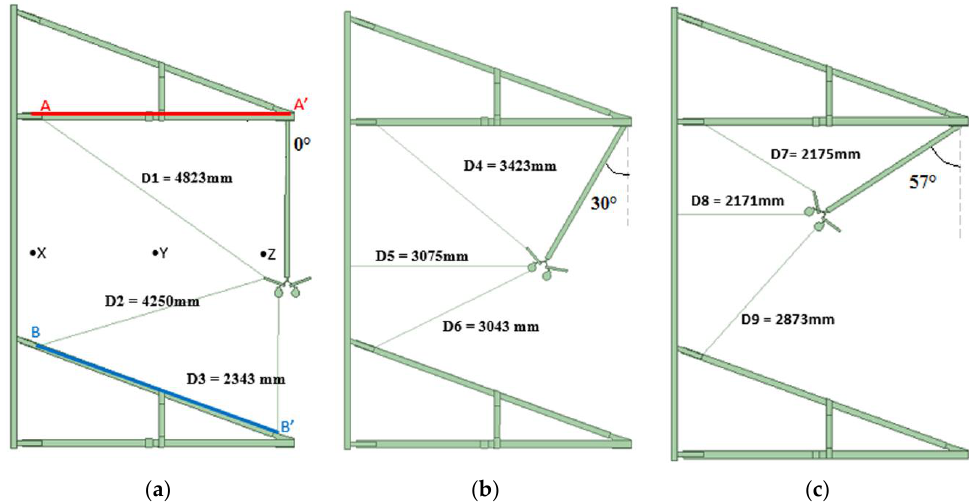
Figure 4. The distance to the nearest earthed metallic object at different swing angles: ( a ) Swing angle of 0°; ( b ) swing angle of 30°; and ( c ) swing angle of 0°. of 0 ◦ ; ( b ) swing angle of 30 ◦ ; and ( c ) swing angle of 0 ◦ . Table 1. Estimated critical flashover (CFO) to the nearest earthed metallic Table 1. Estimated critical flashover (CFO) to the nearest earthed metallic object.